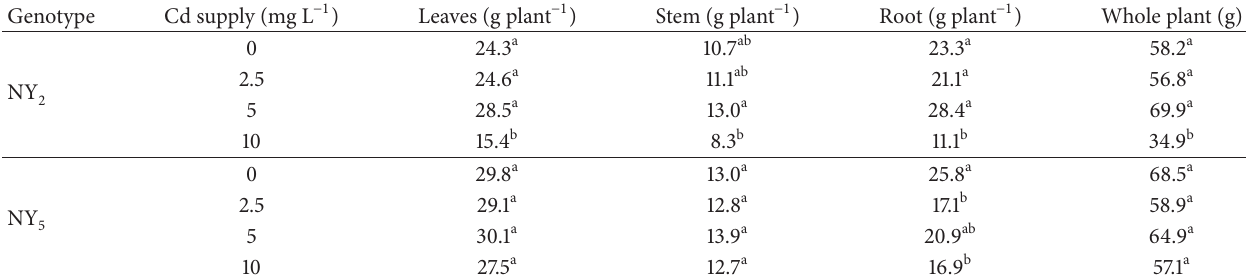
Table 2: Effects of different cadmium treatments on the fresh biomass of two H. tuberosus genotypes.